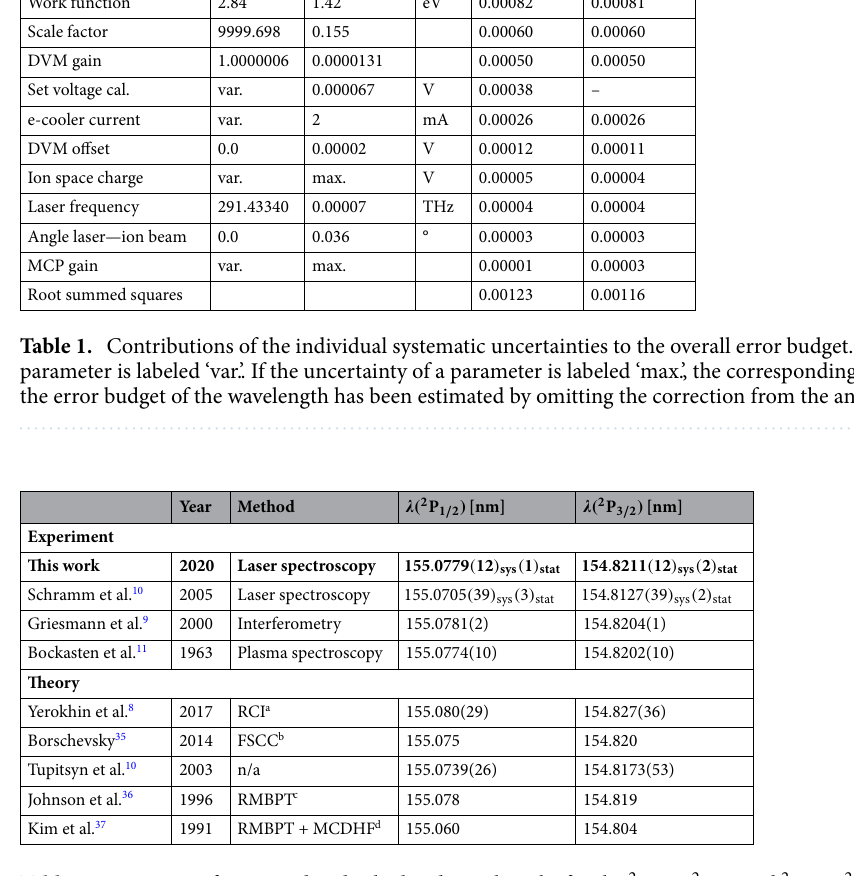
Table 2. Overview of measured and calculated wavelengths for the obtained in this work and available from the literature. a Relativistic configuration interaction. b Fock space coupled cluster. c Relativistic many body perturbation theory. d MultiConfiguration Dirac–Hartree–Fock. Bold values indicate the 1 sigma uncertainties of the